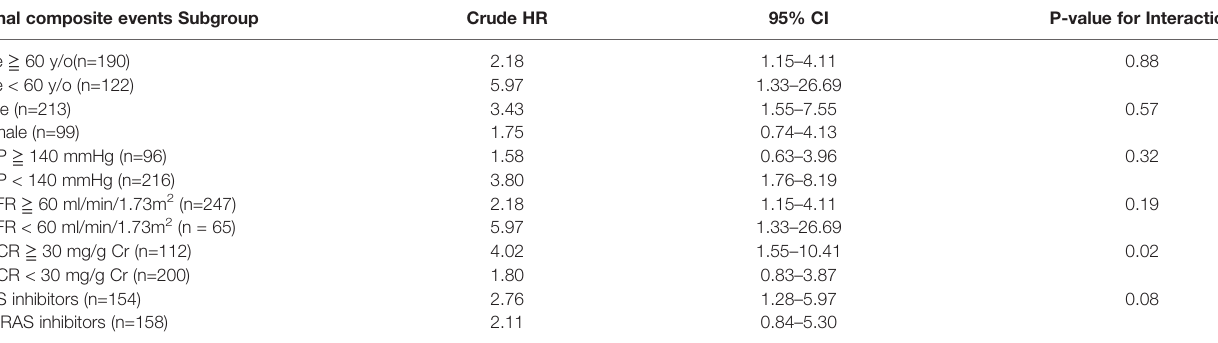
TABLE 4 | Results of association of FGF-21 ≧ 1.40 pg/dl and renal composite events strati fi ed by age, sex, blood pressure, eGFR, UACR, and the use of RAS inhibitors. Renal composite events Subgroup Crude